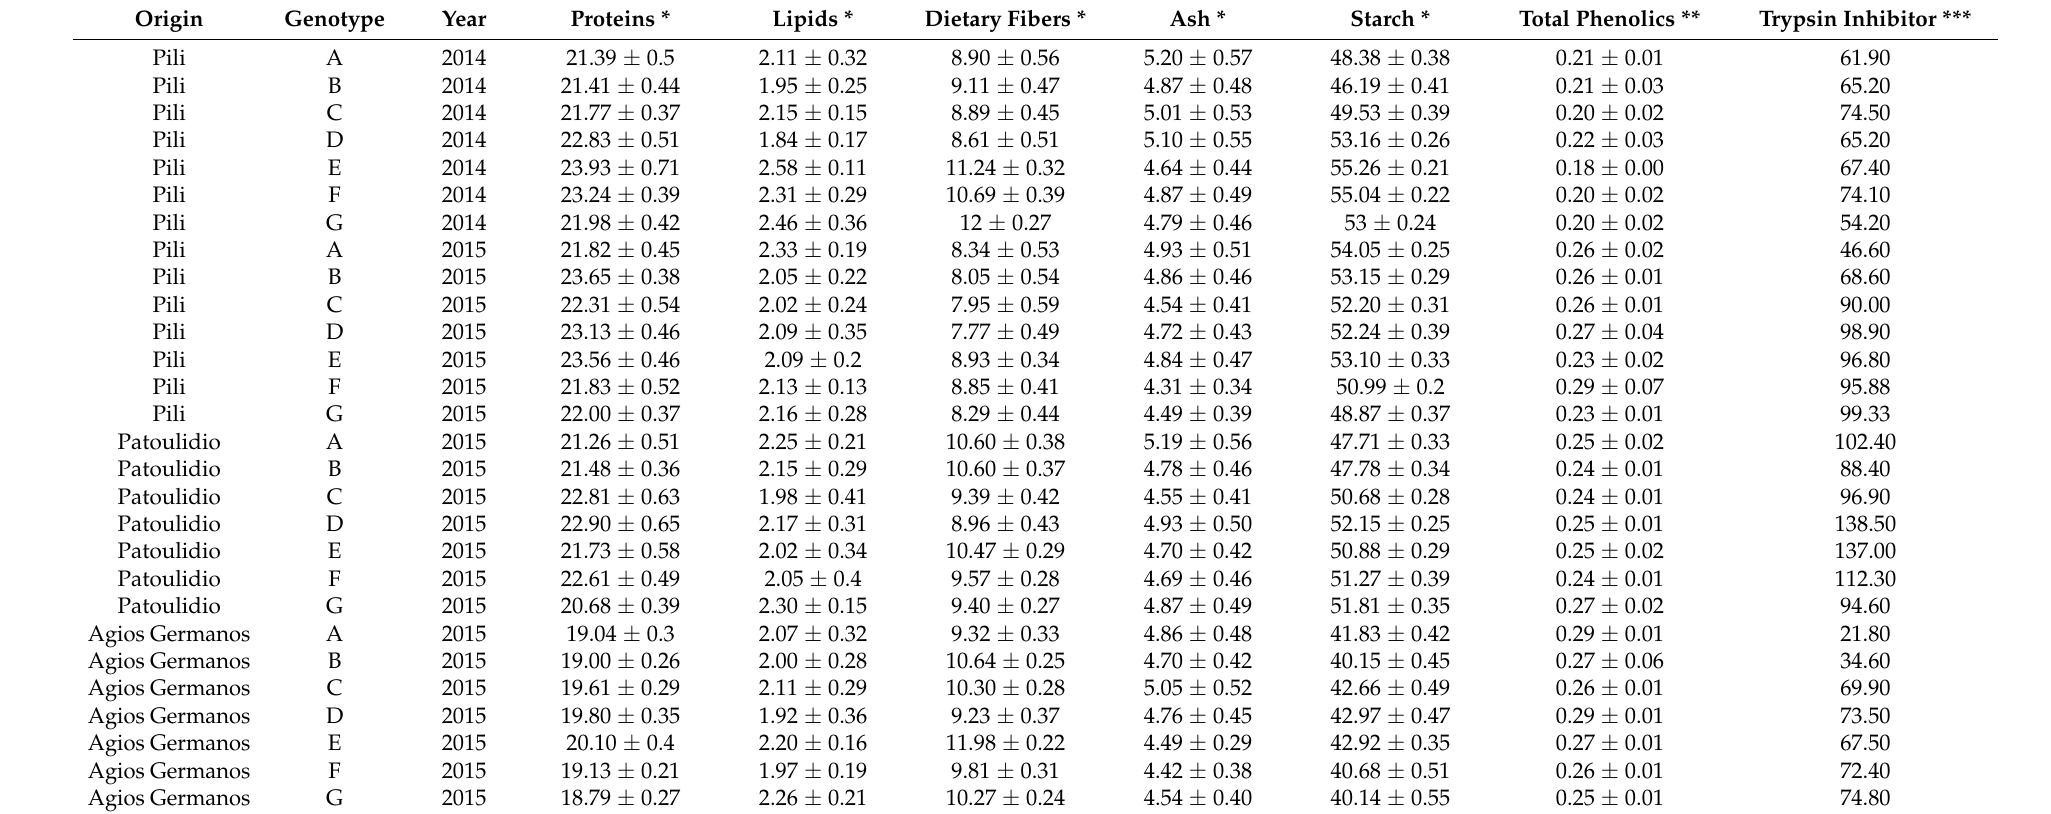
Table 3. Estimation of nutritional and antinutritional components in dry